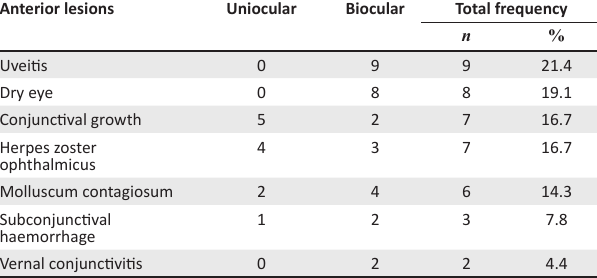
TABLE 5 : Ophthalmic manifestations in the anterior segment of human immunodeficiency virus and acquired immunodeficiency syndrome participants in this study ( n = 42).